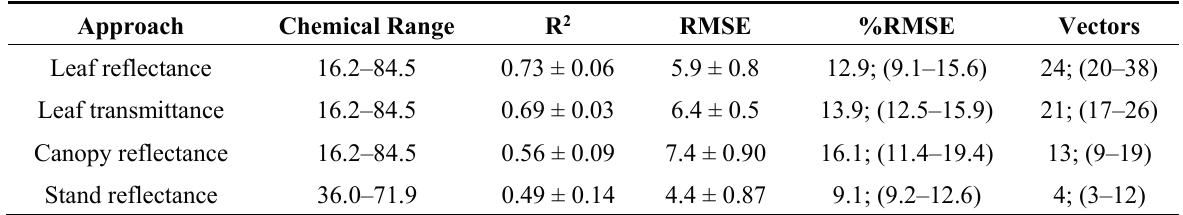
Table 3. Calibration performances for non-structural carbohydrates (NSC) derived from optical spectroscopy in the 400–2450-nm wavelength range at leaf, simulated crown and forest stand levels. Mean ± standard deviation values are presented with minimum